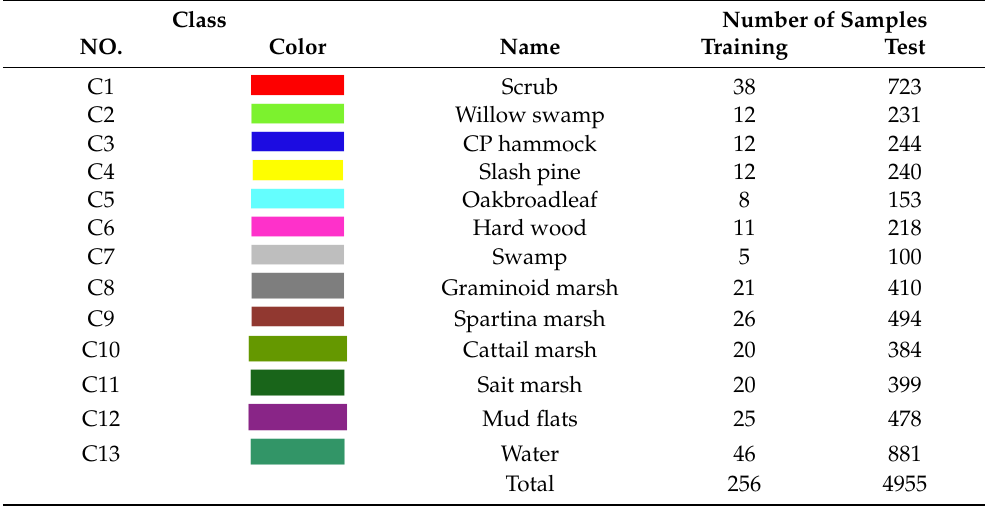
Table 3. Number of training samples and test samples in KSC data set.